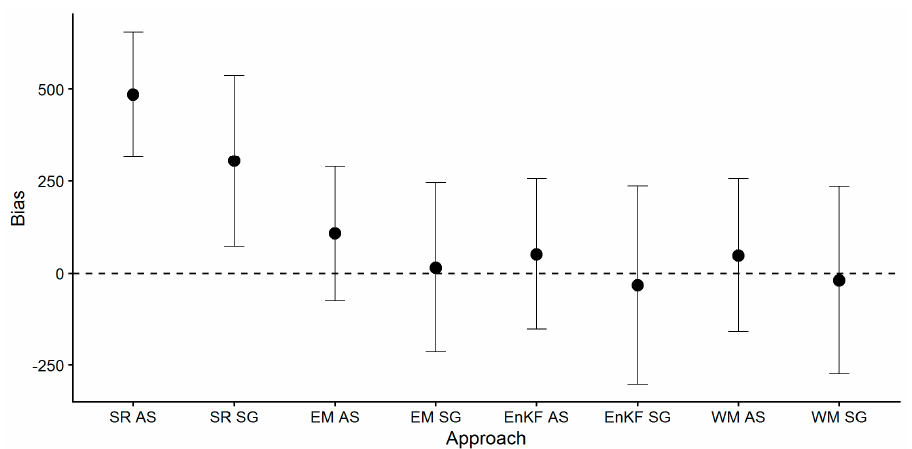
Figure 5 . Average bias and standard deviation of total aboveground biomass for tested approaches.